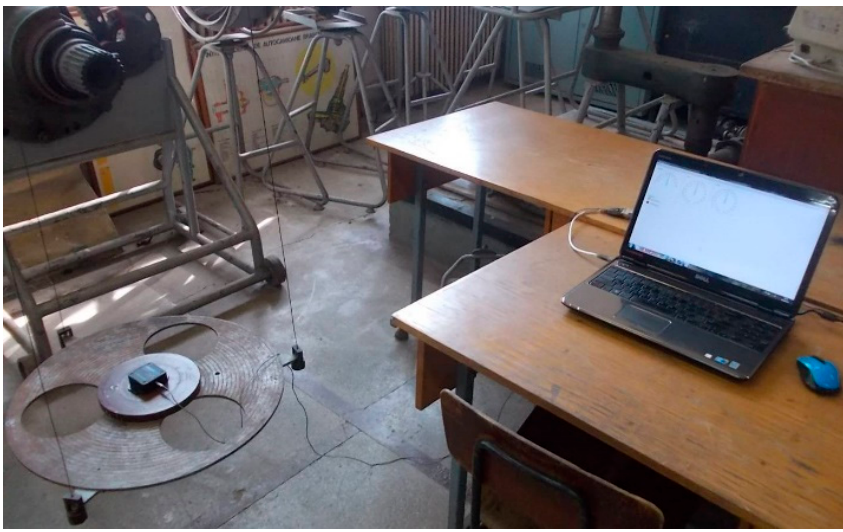
Figure 23. The main elements of the three-wire pendulum measuring chain.